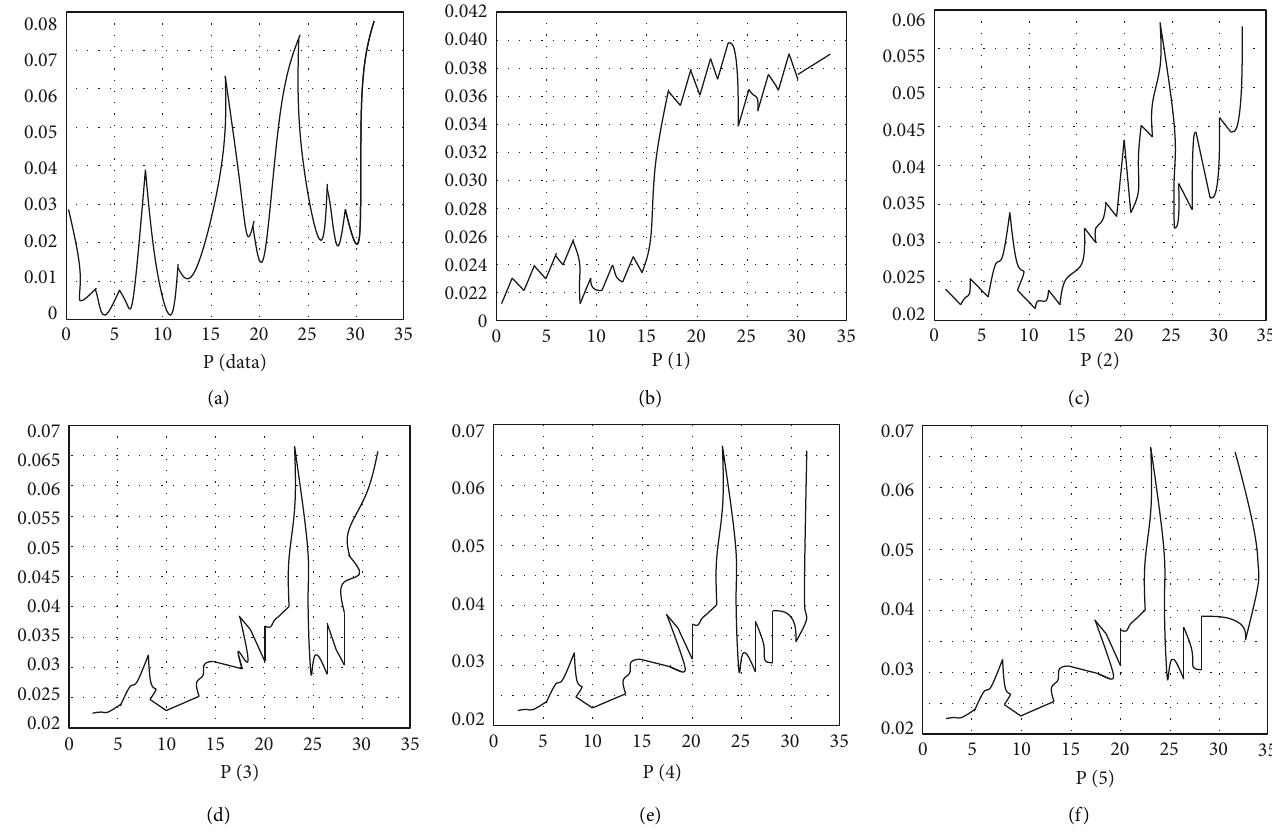
Figure 3: Data and probability values of different language judgment